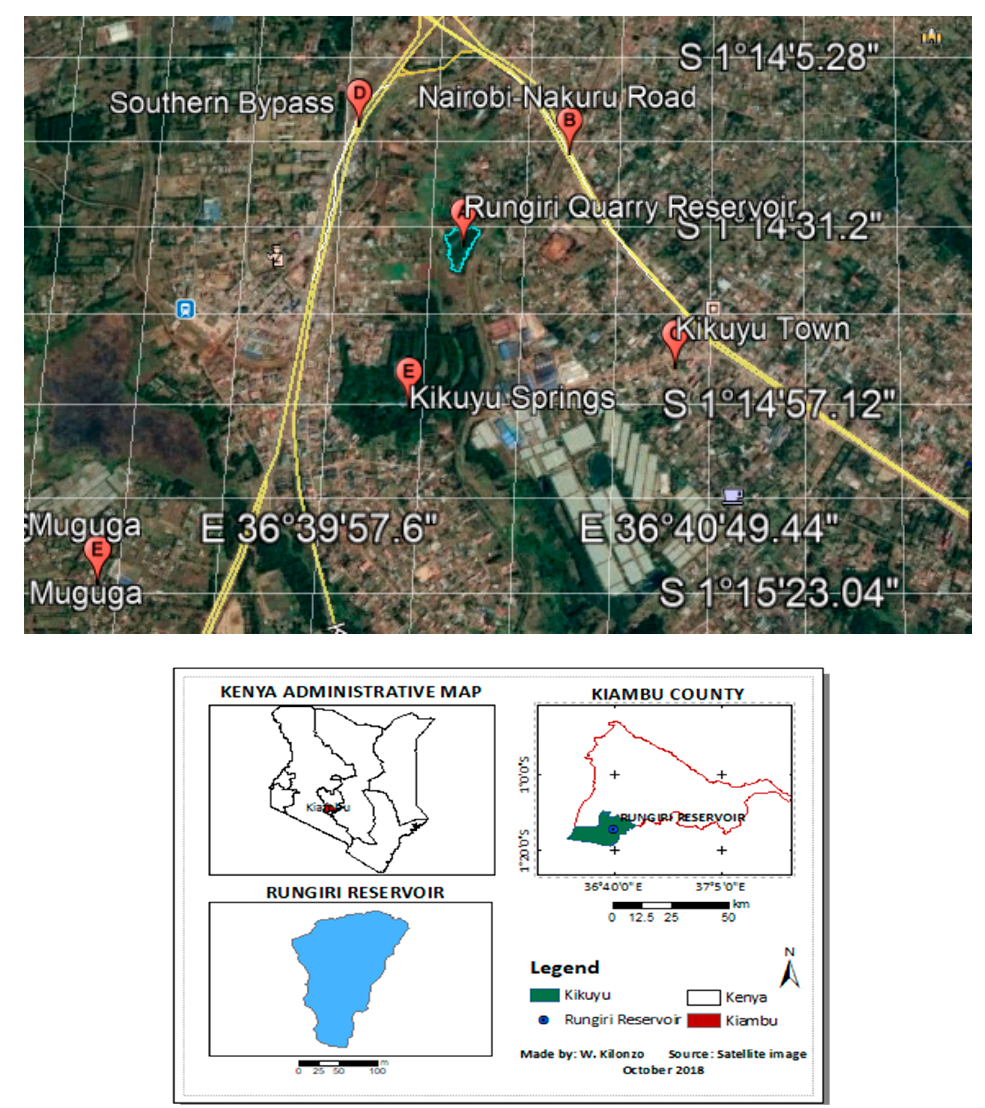
Figure 1. Location map of the study area.